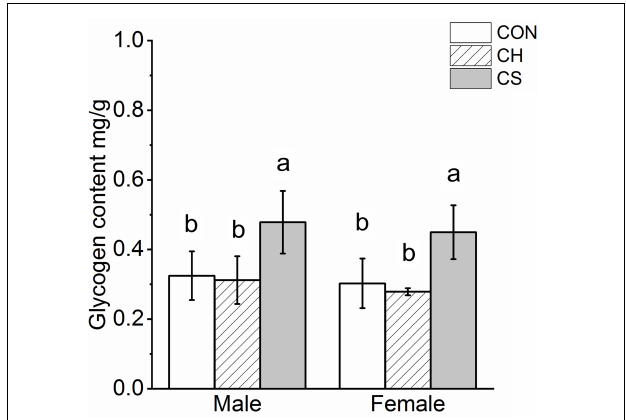
FIGURE 3 | Changes in content of myocardial glycogenosomes in Brandt’s voles. Glycogen levels were normalized by cell protein concentration measured using the BCA assay. Different letters identify statistically significant differences among temperature treatment groups ( P < 0.05). CON, control group; CH, cool huddling group; CS, cool separated group.